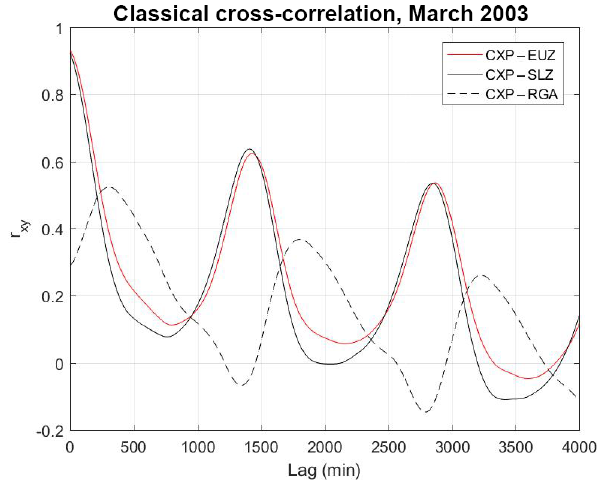
Figure 3. Classical cross-correlation obtained for CXP-EUS, CXP- SLZ, and